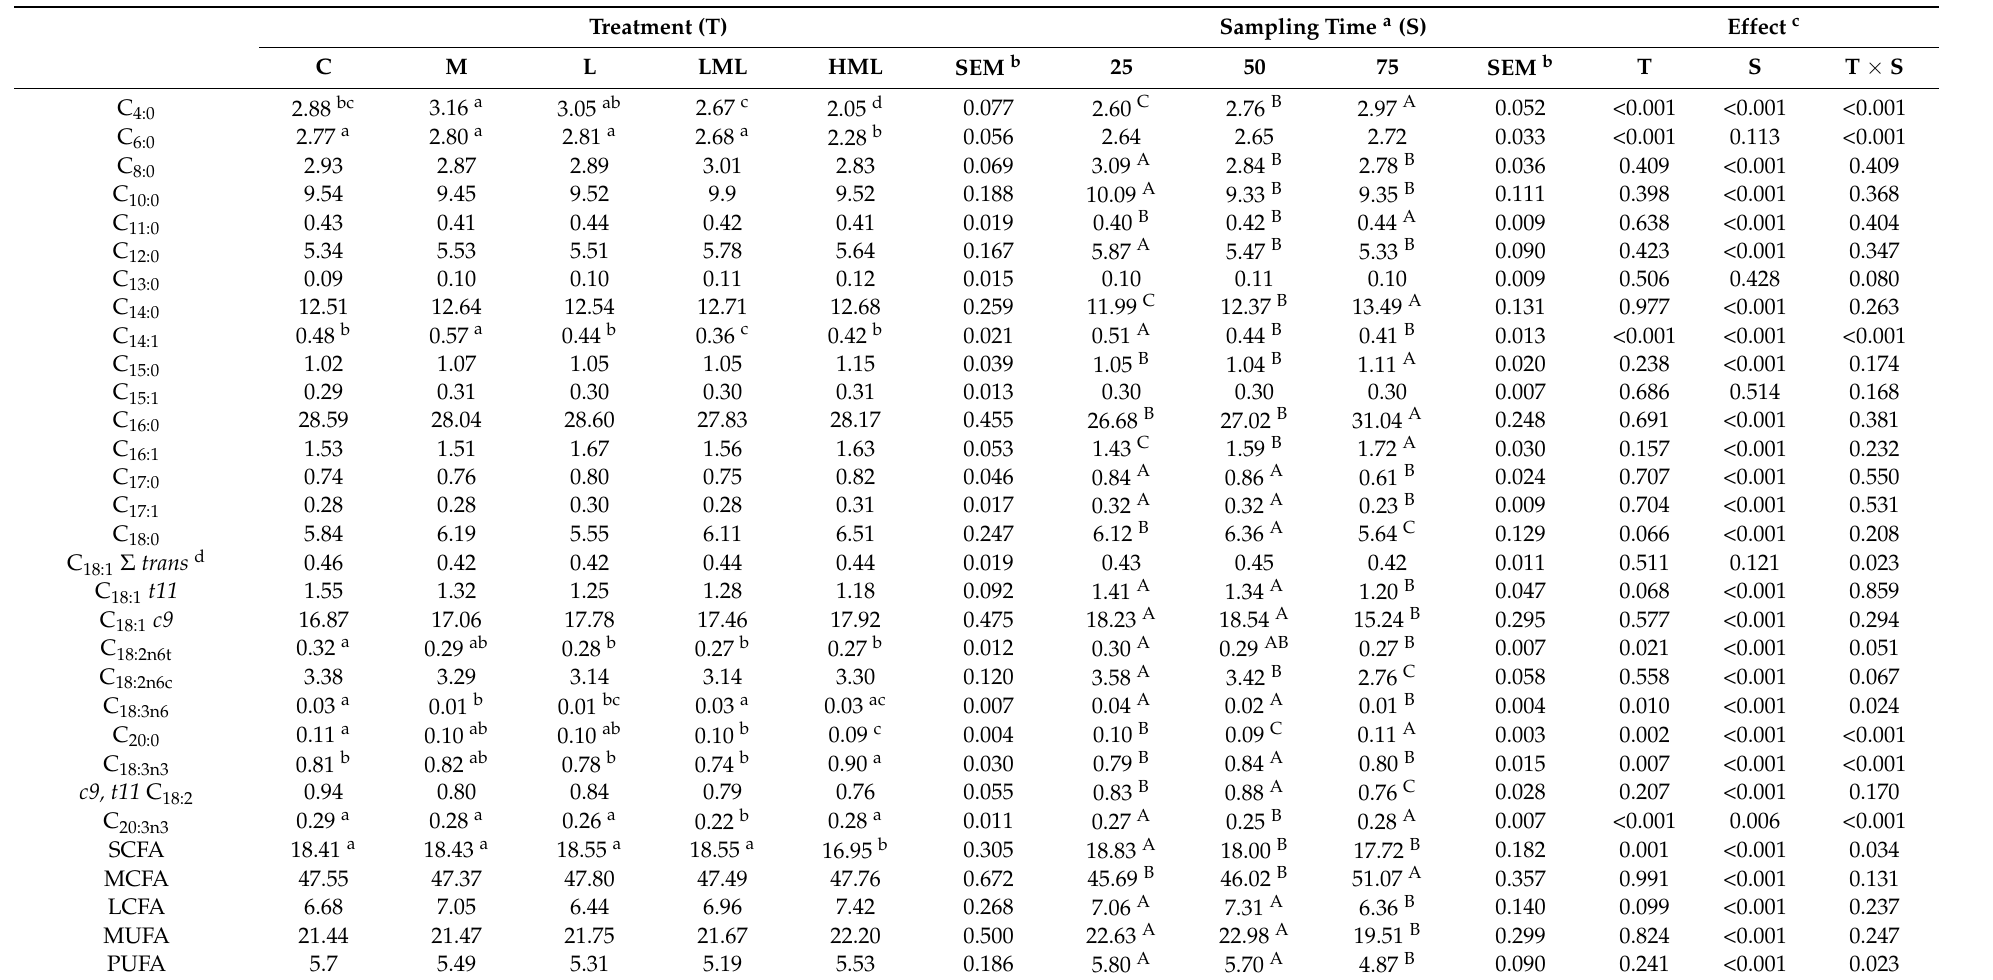
Table 3. The mean individual fatty acids (FA) (% of total FA), FA groups, S/U ratio, the AI index, and ∆ − 9 desaturase index of ewes’ milk. Treatment (T) Sampling Time a (S) Effect